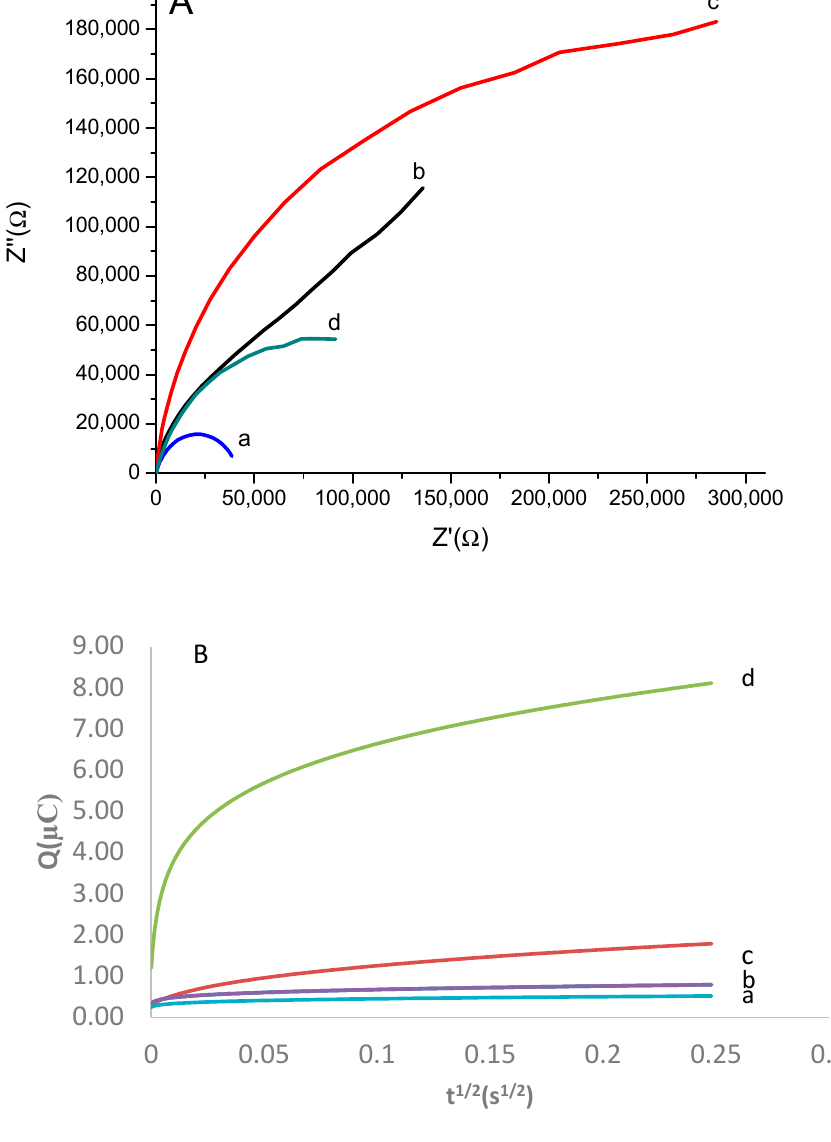
Figure 3. ( A ) EIS curve of (a) CDs / SPCE, (b) CDs / SPCE / Glutraaldhyde, (c) CDs / SPCE / Glutraaldhyde / Aptamer and (d) CDs / SPCE / Glutaraldehyde / Aptamer / Na 2 BH 4 / E2. ( B ) Chronocoulometric responses curve for (a) Bare SPCE, (b) Bare SPCE / Aptamer, (c) CDs / SPCE and